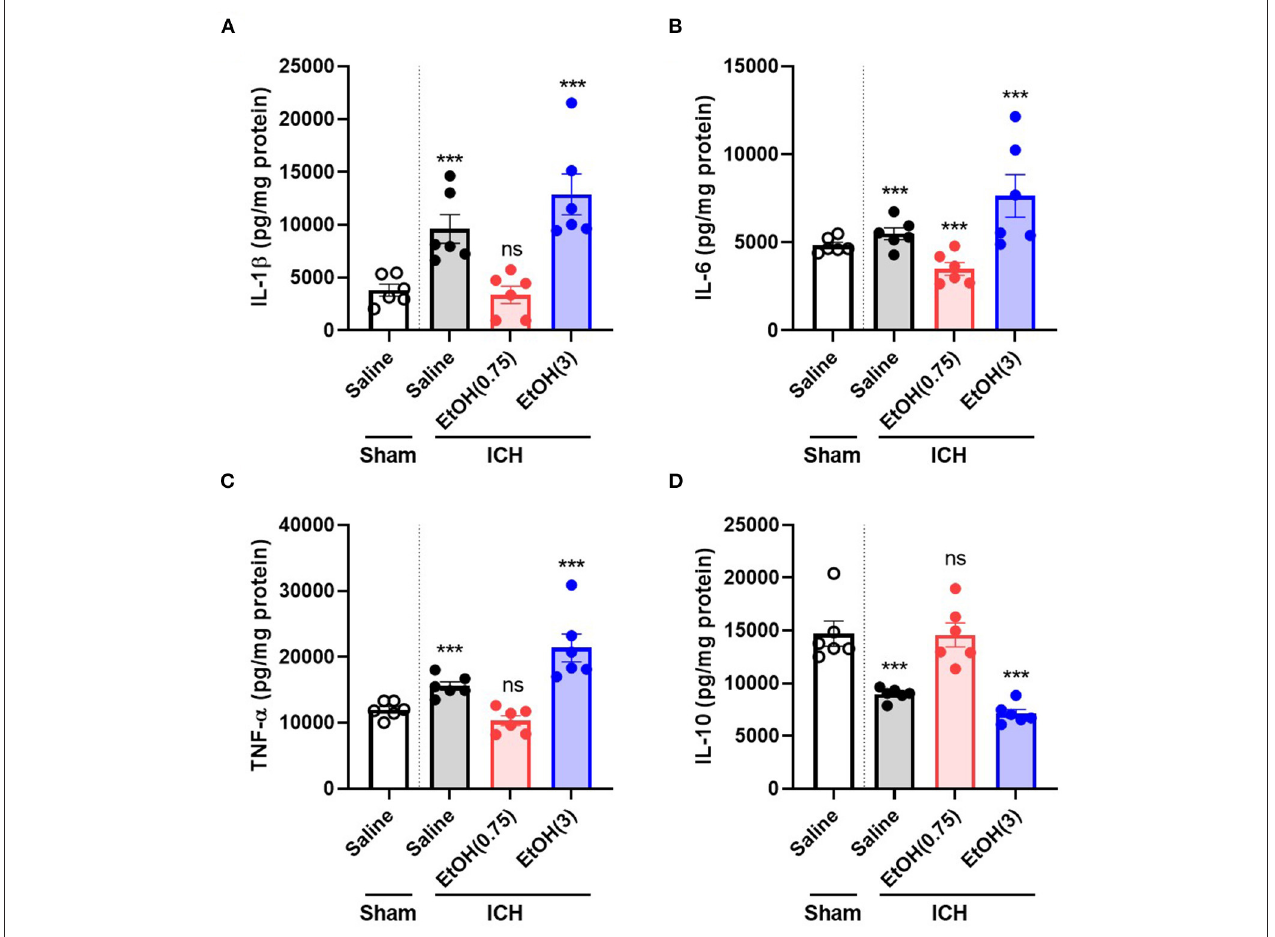
FIGURE 6 | Moderate ethanol pre-conditioning altered proinflammatory cytokines release after ICH injury. (A–D) The levels of IL-1 β (A) , IL-6 (B) , TNF- α (C) , and IL-10 (D) were measured on day 3 post-ICH in each group. Values are shown as means ± SEM ( n = 6). *** p < 0.001 as compared to normal group.